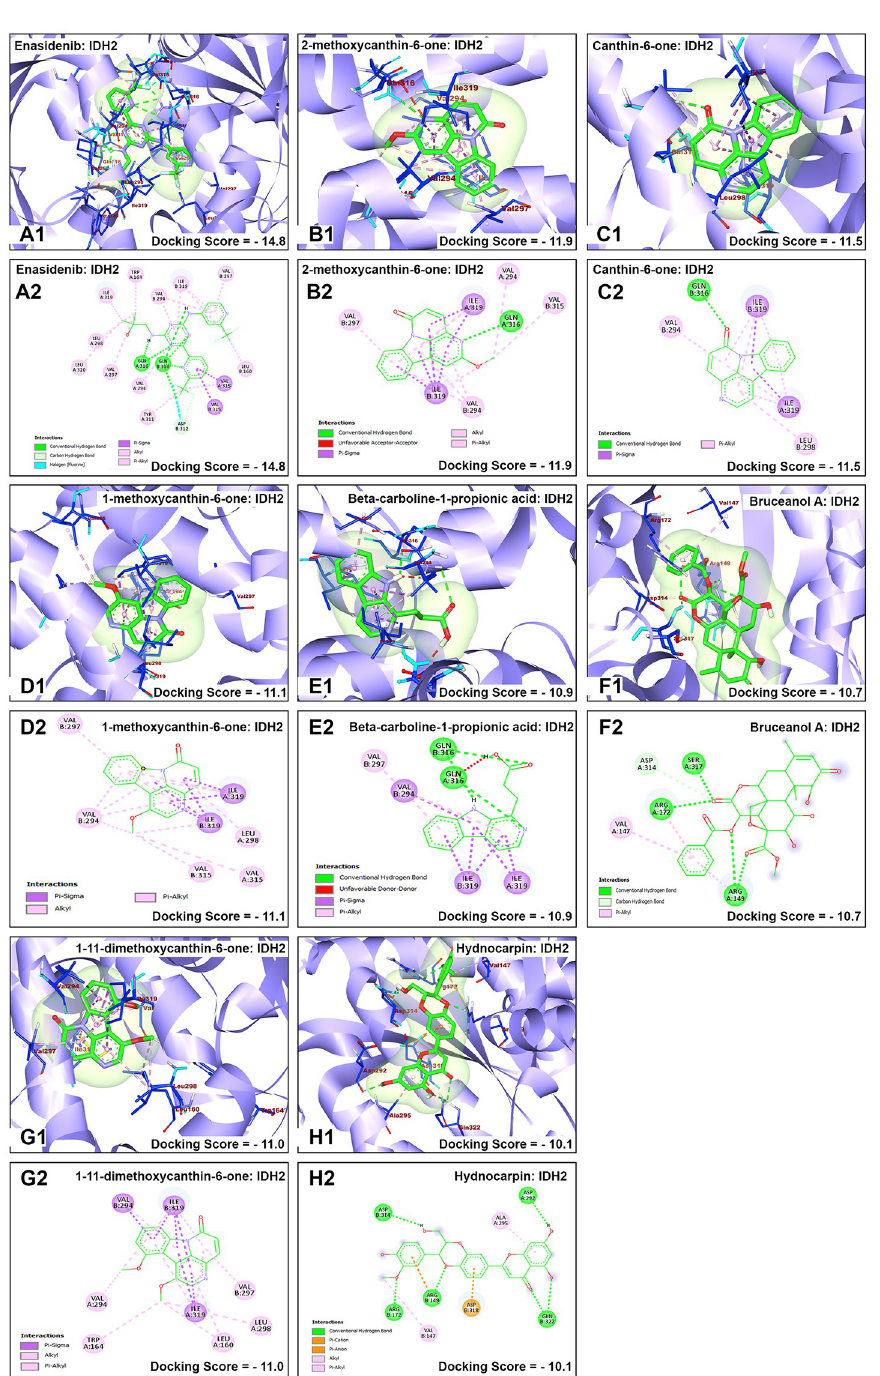
Fig 4. Molecular docking analysis of enasidenib and selected B . antidysentrica phytochemicals against IDH2 AML receptor. (1) 3D pose views of interaction of compounds with AML receptor IDH2. (2) 2D pose views of interaction of compounds with AML receptor